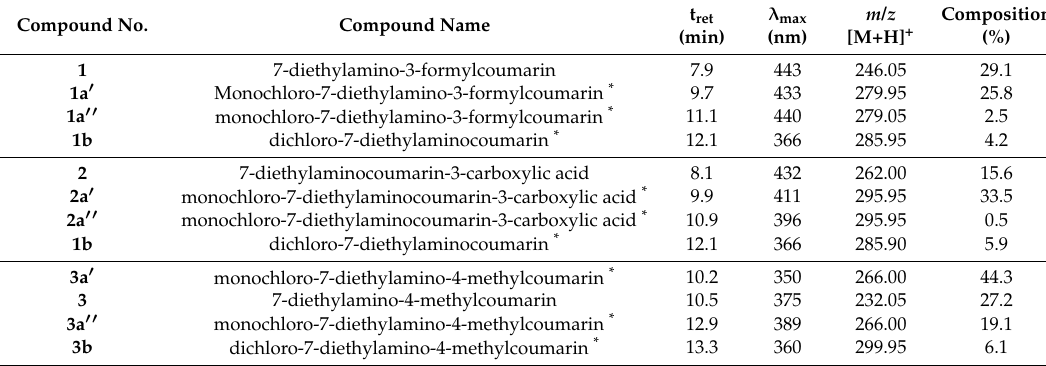
Table 1. Chromatographic, spectrophotometric, and mass spectrometric data for the coumarin derivatives 1 – 3 and their corresponding chlorinated products at pH 3 after 15 min of reaction with